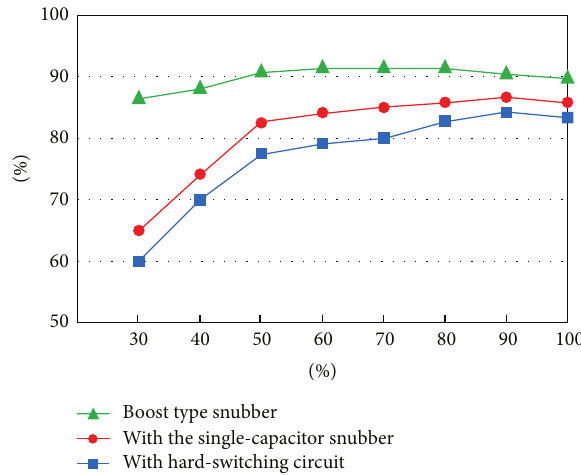
Figure 13: Comparison the efficiencies between the discussed inter- leaved boost converter with hard switching, with the single-capac- itor snubber, and with boost type snubber from light load to heavy load.